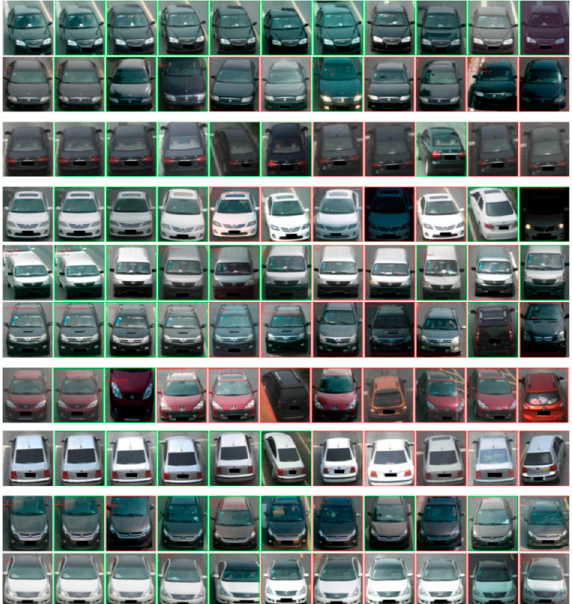
Figure 11. Visualization results for the ranking list of VehicleID.